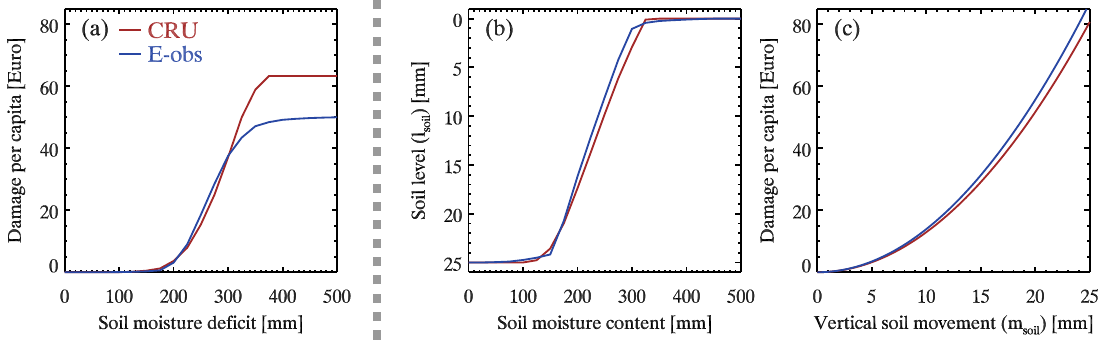
Fig. 3. Vulnerability curves for simulations with the soil moisture deficit indicator (a) . Soil shrinkage (b) and vulnerability (c) curves for simulations with the explicit indicator for drought-induced soil subsidence.